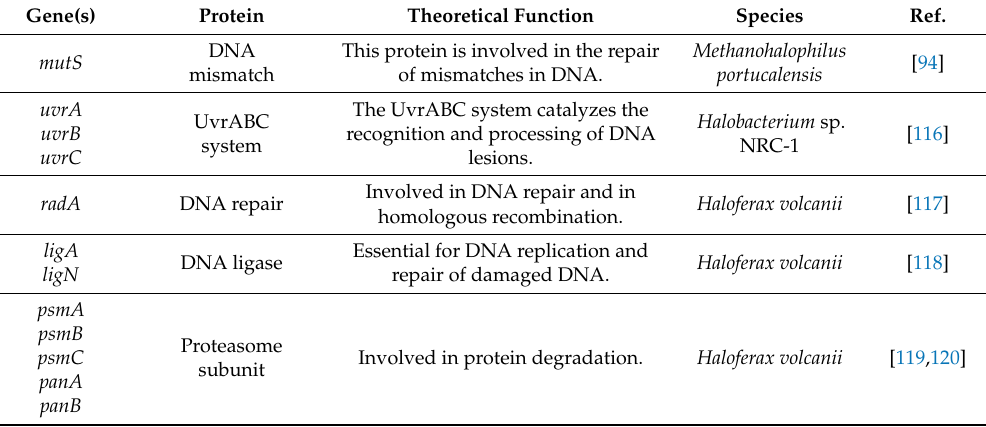
Table 4. Examples of stress genes involved in protecting the cell from unfavorable external conditions, identified in halophilic archaea. Protein Theoretical Function Species Ref. This protein is involved in the repair DNA of mismatches in DNA. mismatch The UvrABC system catalyzes the recognition and processing of DNA lesions. Involved in DNA repair and in radA DNA repair homologous recombination. ligA Essential for DNA replication and DNA ligase ligN repair of damaged DNA. Proteasome Involved in protein subunit